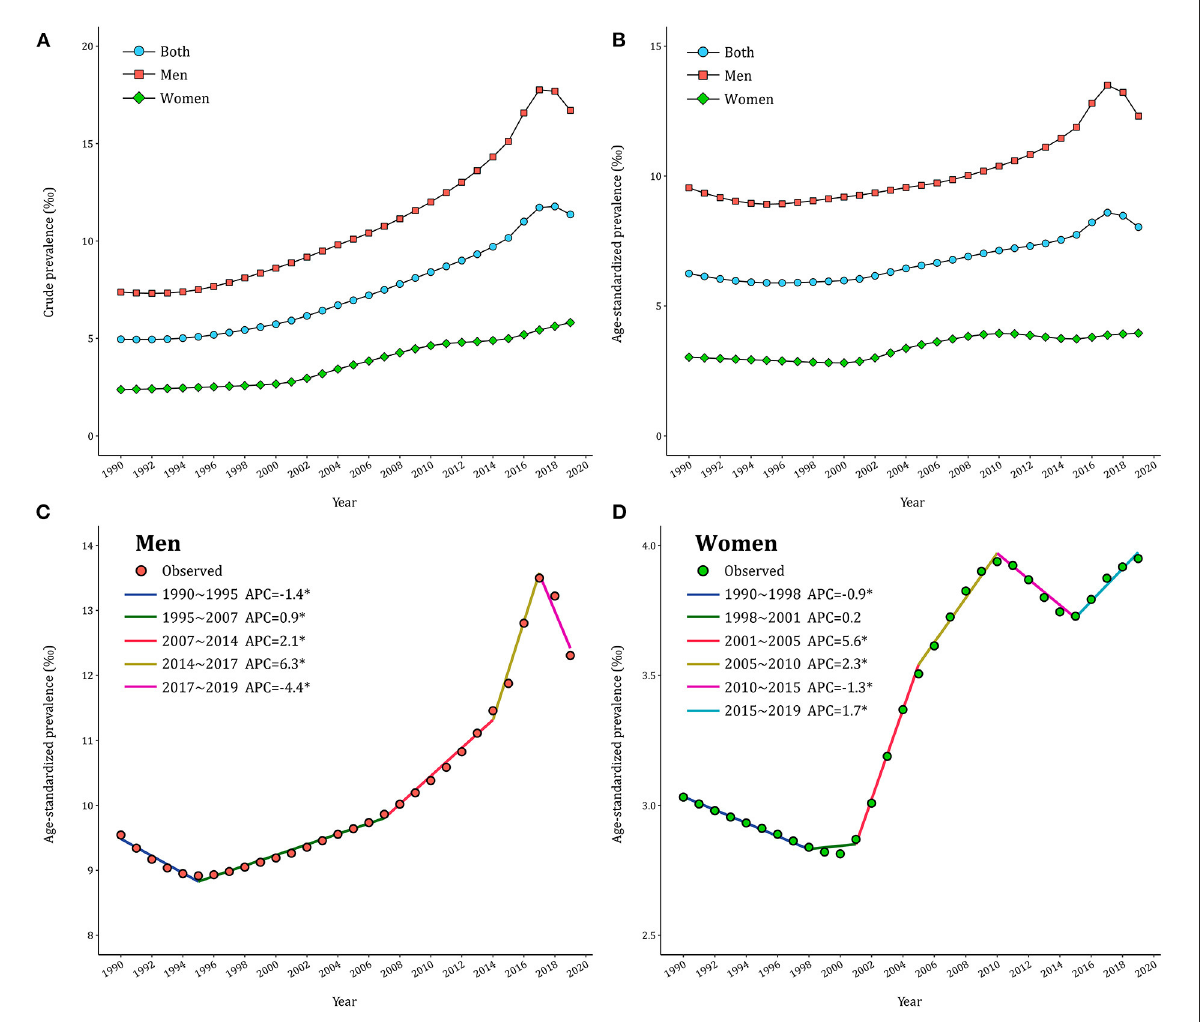
FIGURE1 Trends of gout prevalence in China during 1990–2019. (A) Crude prevalence of gout. (B) Age–standardized prevalence of gout. (C,D) APCs of the age–standardized prevalence of gout for men and